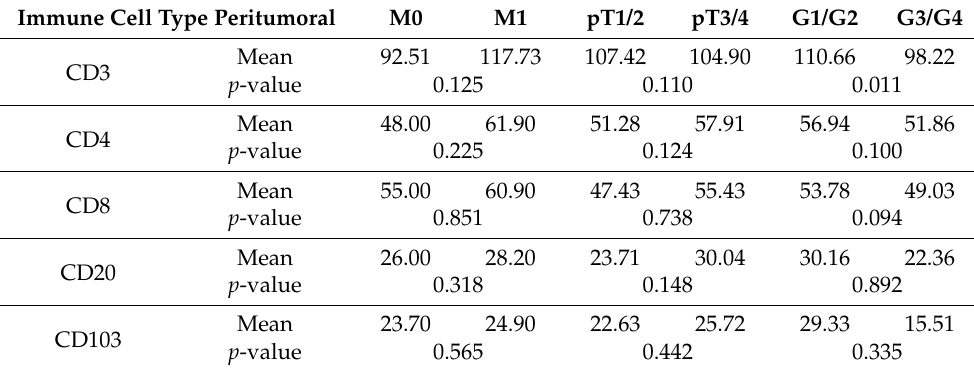
Table 3. Comparison of peritumoral immune cell infiltrate and clinico-pathological data (Mann– Whitney U test, Bonn cohort, n = 50 patients).